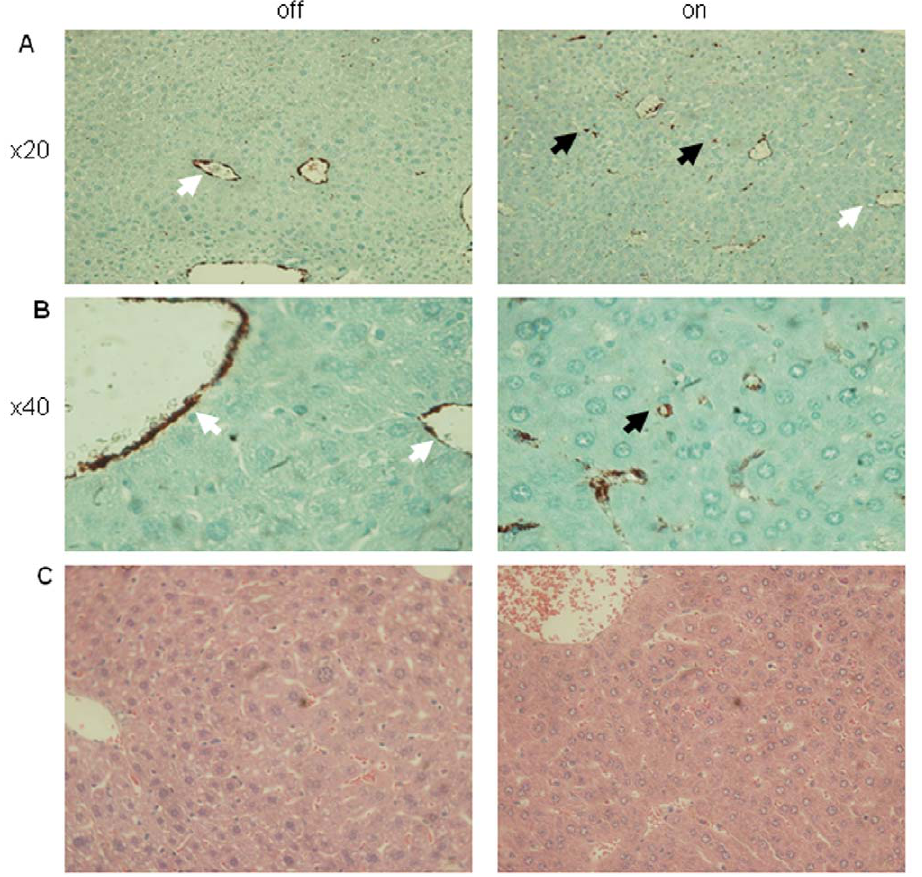
Figure 4. Sinusoidal capillarization in sVEGF-R1 expressing livers without parenchymal damage. (a,b) Immunohistochemical staining for vWF (Von-Willebrand Factor) on liver sections (black arrows-sinusoids, white arrows-larger blood vessels). (c) H&E staining of liver sections showing normal appearance.